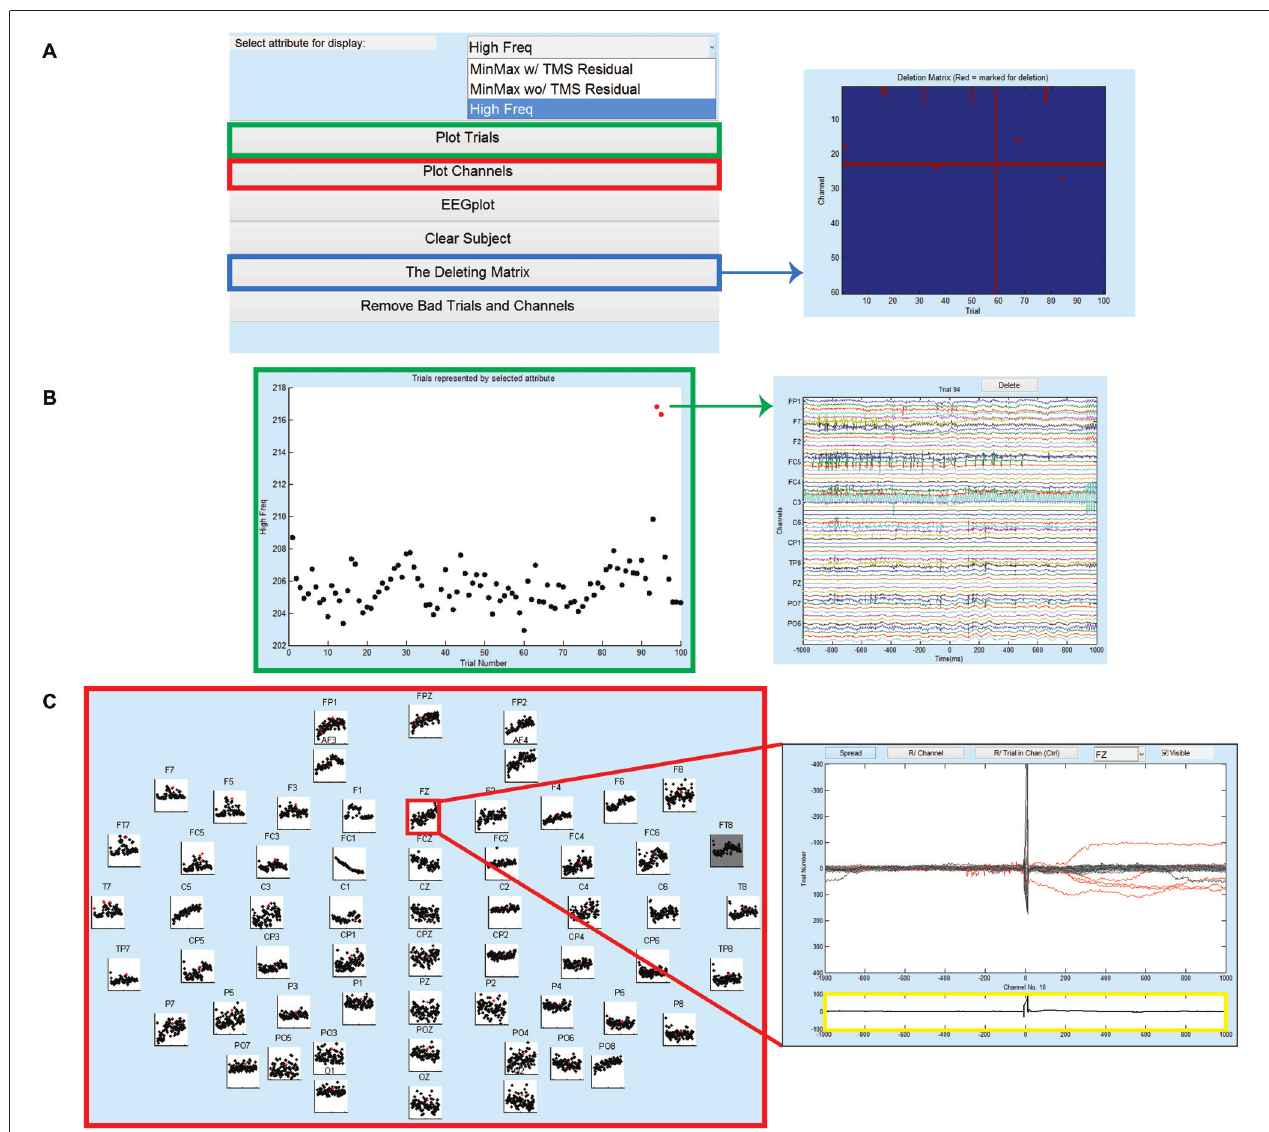
FIGURE 5 | Step 3 GUI for data cleaning. (A) The GUI for Step 3 is shown on the left. Right panel depicts the CHAN_DELETION matrix displaying the trials and channels tagged for removal. This matrix provides a visual inspection of deleted data for quality control ( x -axis is the trial number and y -axis is the channel number). In the main GUI, the user can select an ATTRIBUTE value for data display using the drop-down menu. (B) GUI for Plot Trials, displaying trials by their average ATTRIBUTE value (left); x -axis is the trial number and y -axis is the ATTRIBUTE value. Selecting a single dot opens the corresponding trial data (right), and in this window the user can choose to delete the entire trial (dot becomes red) or selectively remove specific channels in the trial. In the right window, x -axis represents time in milliseconds relative to presentation of TMS pulse and y -axis is the channel labels. (C) GUI for Plot Channels, displaying trials by their average ATTRIBUTE value for every channel (left). Selecting a channel’s scatter plot opens the corresponding channel data (right) and in this window the user can choose to delete the entire channel (scatter plot turns dark gray) or selectively remove specific trials within the channels (trials are marked in red and corresponding dot in scatter plot turns red). In the right window, x -axis represents time in milliseconds relative to presentation of TMS pulse and y -axis represents the amplitude of the EEG signal in µ V. The bottom plot in the right window (highlighted in yellow) is the mean TEP (averaged across trials) for the selected